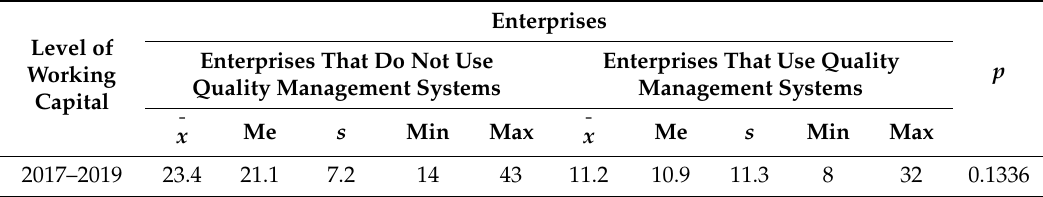
Table 2. Level of working capital (in